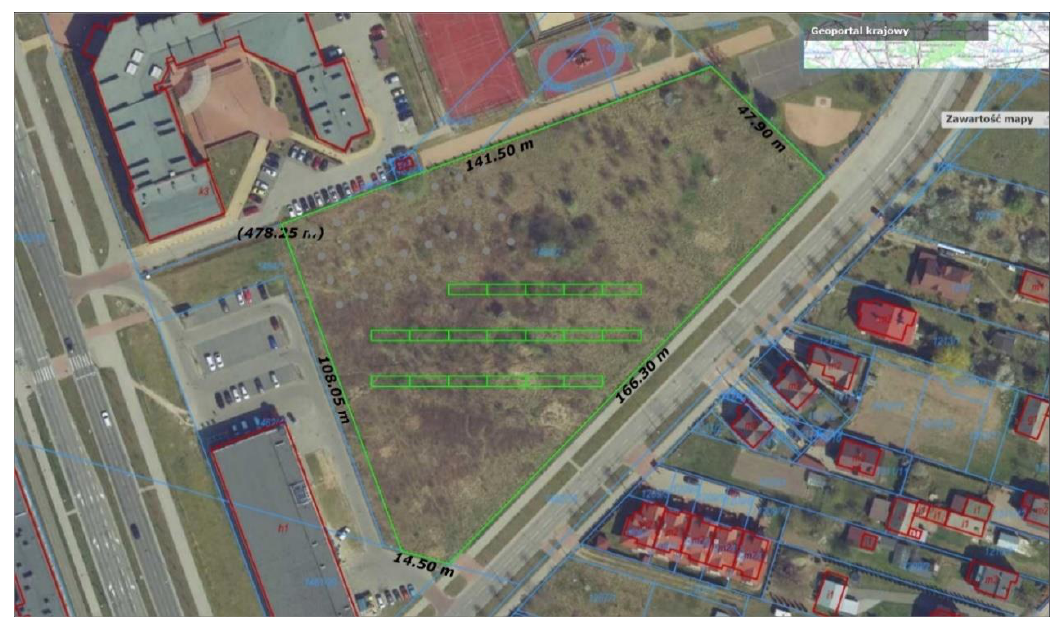
Figure 7. Placement of 4 × 7 photovoltaic panels on a neighbouring plot.